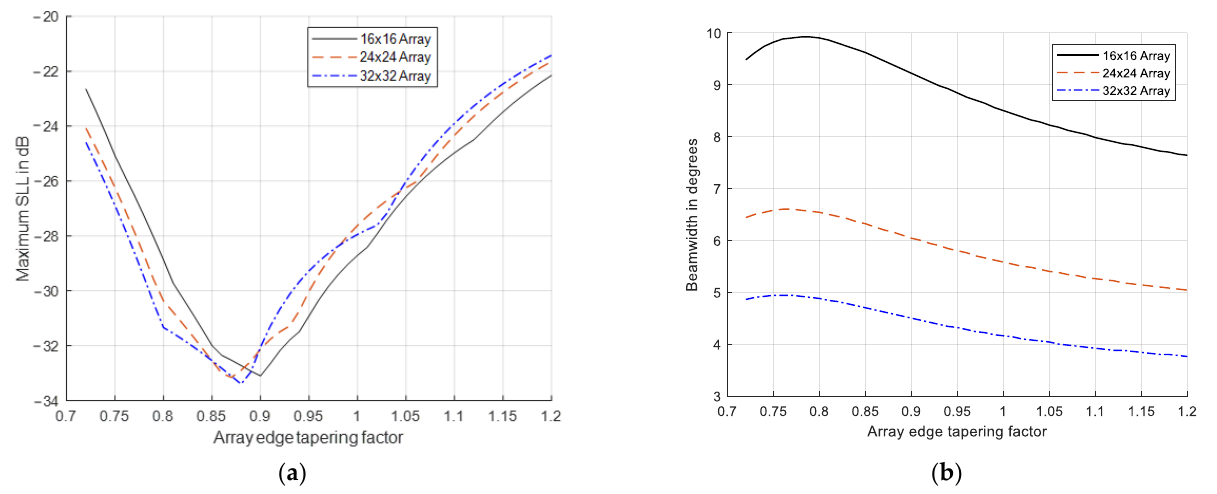
Figure 10. ( a ) Optimizing radial tapered cosine-square window at different array sizes. ( b ) Beamwidth variation with the array edge tapering factor at different array sizes.